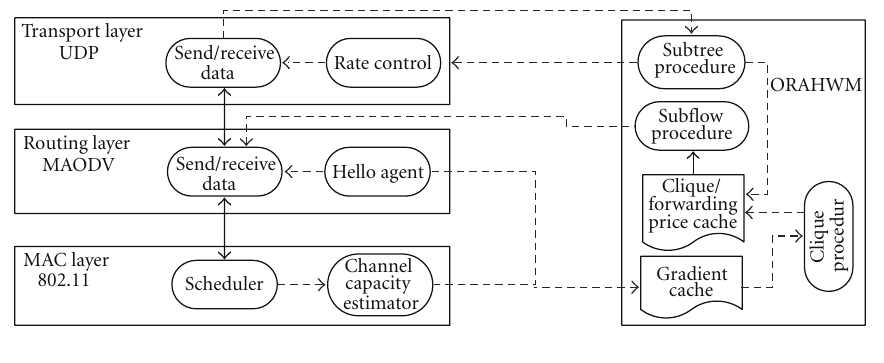
Figure 3: Cross-layer architecture for